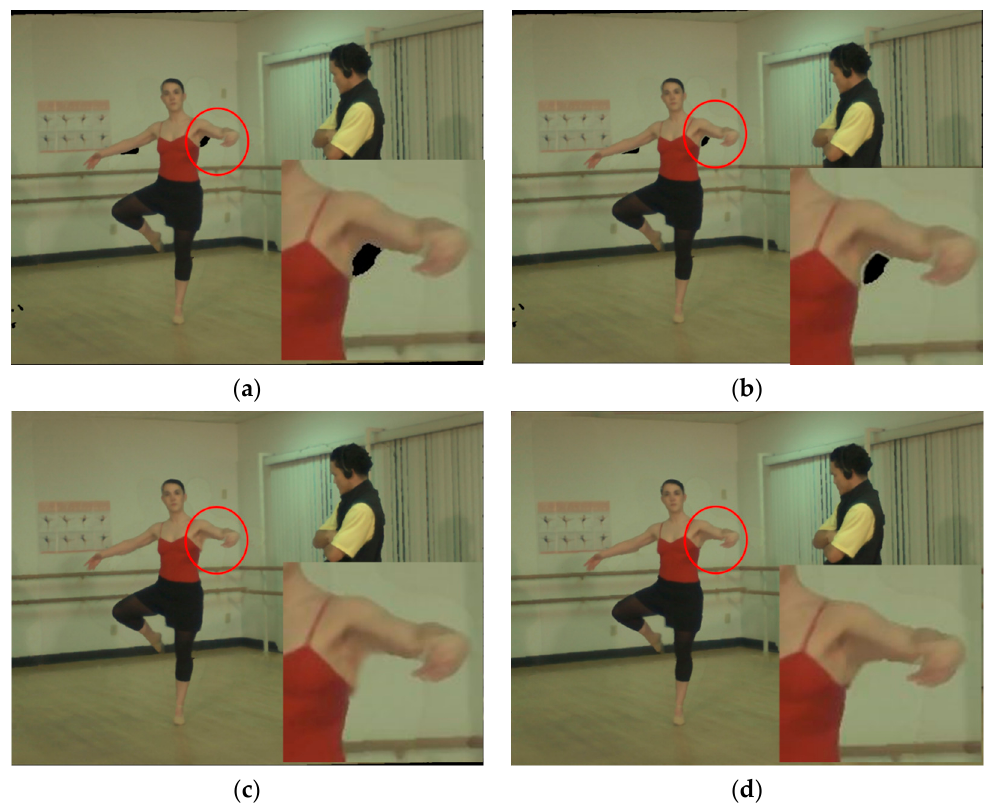
Figure 14. Inpainting results. ( a ) View with holes, ( b ) boundary replacement, ( c ) inpainting result of ( a ), and ( d ) proposed inpainting result corresponding to ( b ).